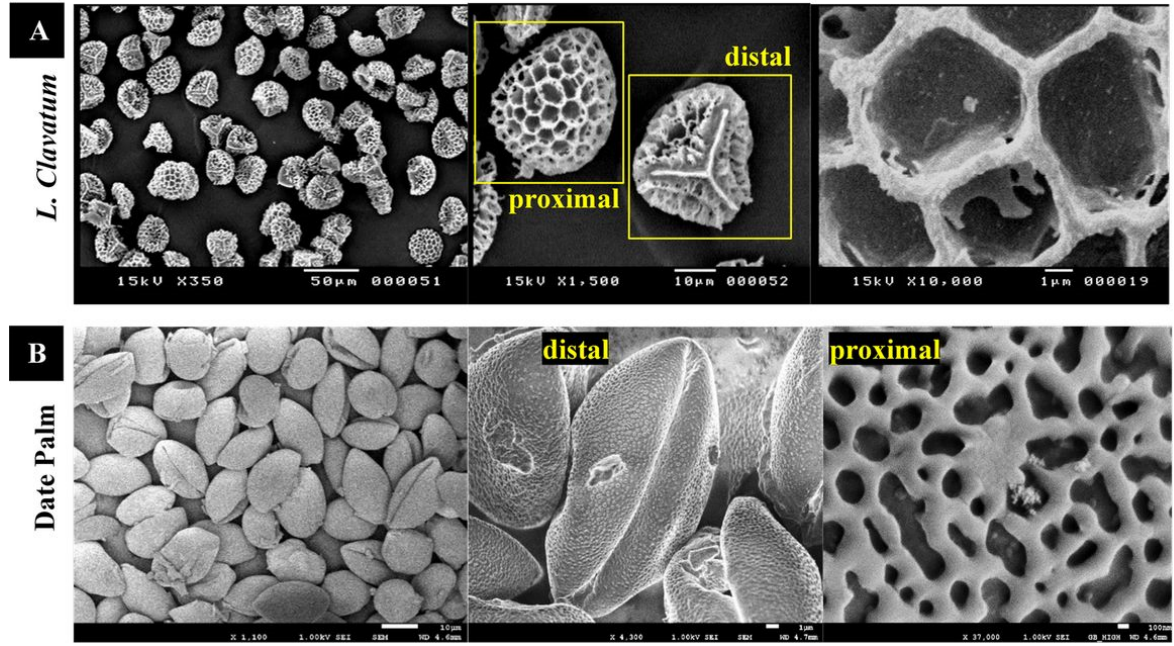
Figure 2. SEM images of raw pollens’ species showing their surface morphology at different magnifications. ( A ) Lycopodium clavatum and ( B ) date palm.